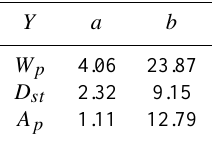
Table 1. Coefficients of model representing storms number in terms of the phase of the solar